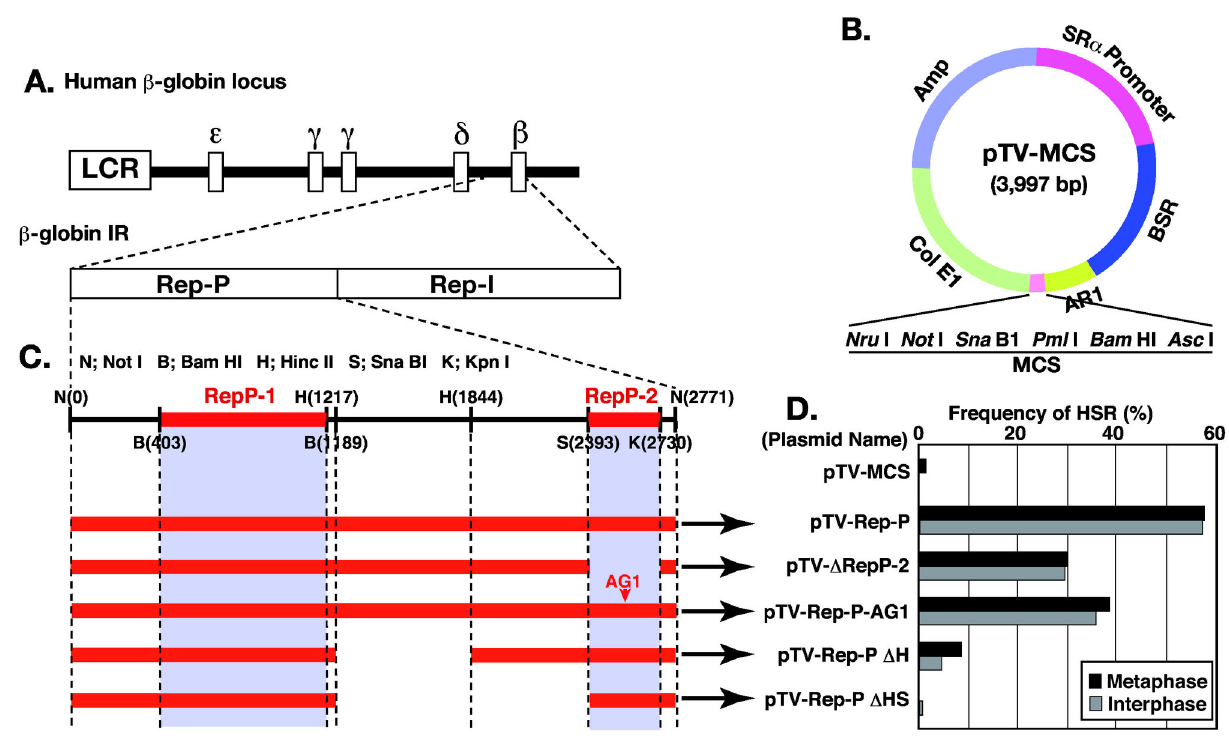
Figure 2. Dissection of the ß-globin replicator using a plasmid-stability assay. (1) . The ß-globin locus and the positions of two reported replicators, Rep-P and Rep-I [20], are drawn in A. We inserted wild type Rep-P as well as fragments bearing four deletions or an AG1 point mutation (orange bars in C) into the Not I site of the vector plasmid pTV-MCS (B). In panel C, RepP-1 and RepP-2 regions are indicated as gray rectangles. The plasmids were transfected into COLO 320DM cells, and polyclonal transfectants were selected in blasticidine for about 1 month. Metaphase spreads from these cells were analyzed by FISH using a pTV-MCS plasmid-derived probe. The frequencies of cells bearing HSRs of plasmid repeats were scored in both metaphase and the interphase cells, and the data are plotted in panel